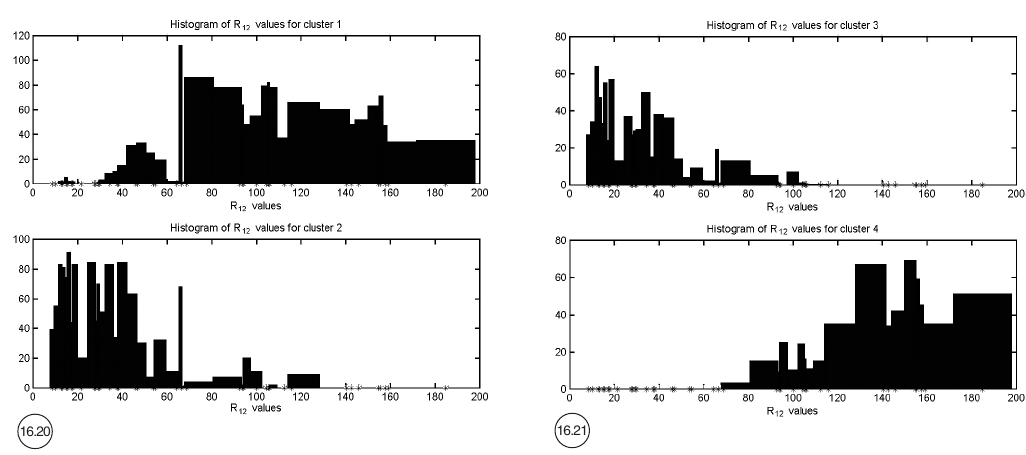
Fig. 16.20. Histogram of R 12 values (from 8.6 to 184.8), for Cluster 1 and Cluster 2. Fig. 16.21. Histogram of R 12 values (from 8.6 to 184.8), for Cluster 3 and Cluster